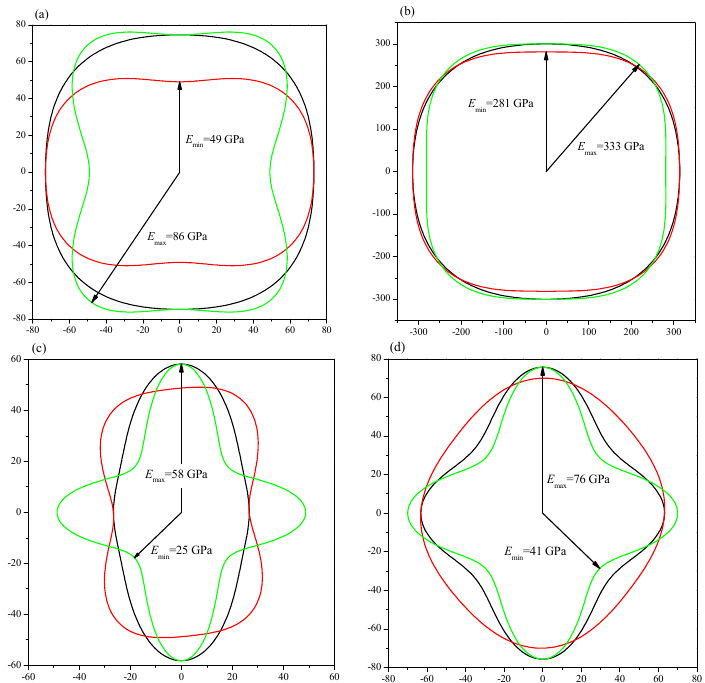
Figure 7. 2D representations of the Young’s modulus. ( a ) Pnma -Ca 2 C at 0 GPa; ( b ) Pnma -Ca 2 C at 100 GPa; ( c ) C 2/ m -Ca 2 C at 0 and 6 GPa; ( d ) C 2/ m -Ca 2 C at 6 GPa. The black, red and green lines represent the xy , xz and yz planes, respectively.